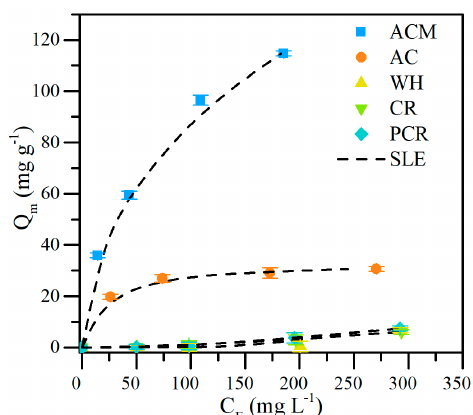
Figure 9. Comparison between adsorption isotherms of crude oil over walnut shell (WH), coffee residue (CR), the pyrolyzed coffee residue (PCR), the synthesized activated carbon (AC), and activated carbon modified with 5.0 wt.% of magnetite nanoparticles (ACM). pH = 7.15, temperature = 25 °C, and the adsorbent dose was 1 g L − 1 . Table 3. Adjustment parameters of Solid Liquid Equilibrium (SLE) model for adsorption isotherms.